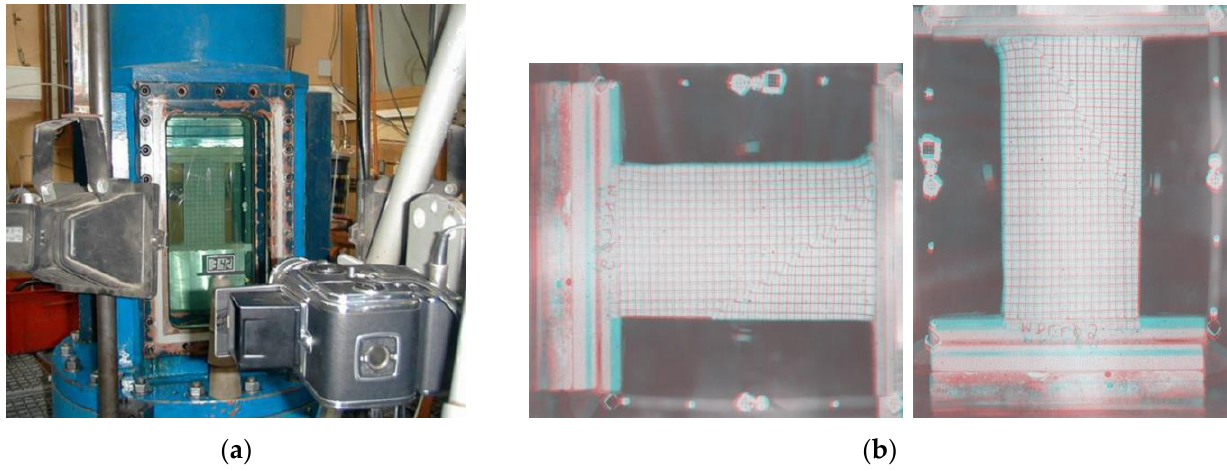
Figure 11. Test stand with the use of stereophotogrammetry in Laboratory S3R: ( a ) biaxial apparatus with two-camera system (source: phot. of Jacques Desrues, 1999); ( b ) camera record at the moment of failure (source: phot. of Leonardo Lenti, 2000); (after [109], available via 2021 Desrues’ permission).